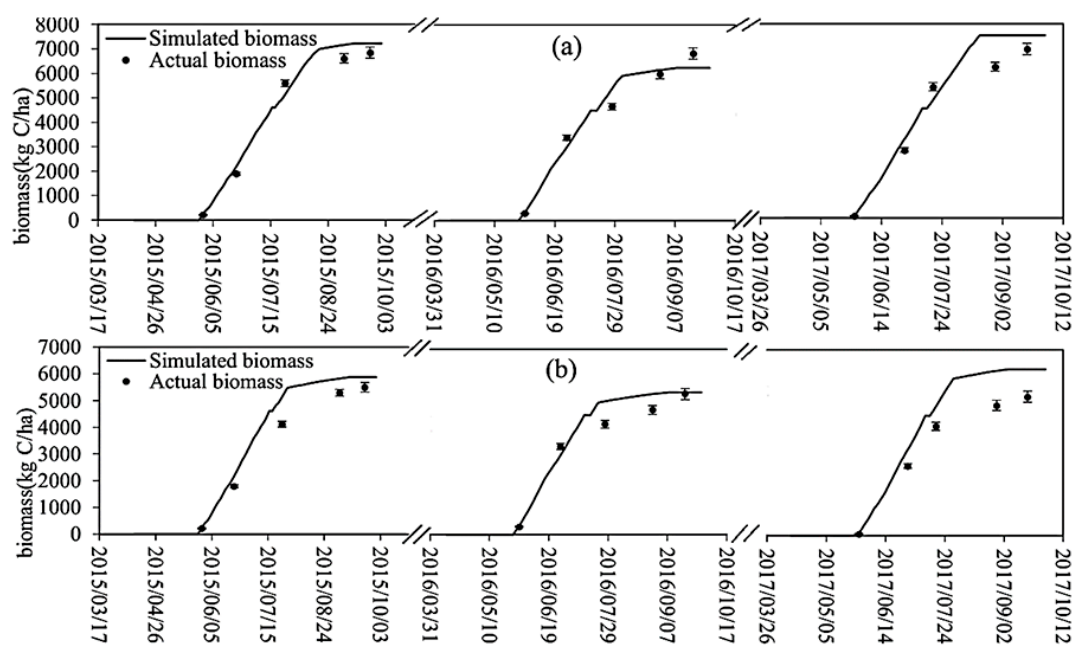
Figure 6. DeNitrification-DeComposition (DNDC) model simulation results for maize biomass under ( a ) degradable mulch film and ( b ) bare land cultivation techniques. When mulching was used, the root mean square error ( RMSE), the coe ffi cient of determination (R 2